Question: Draft a figure caption describing what is shown.
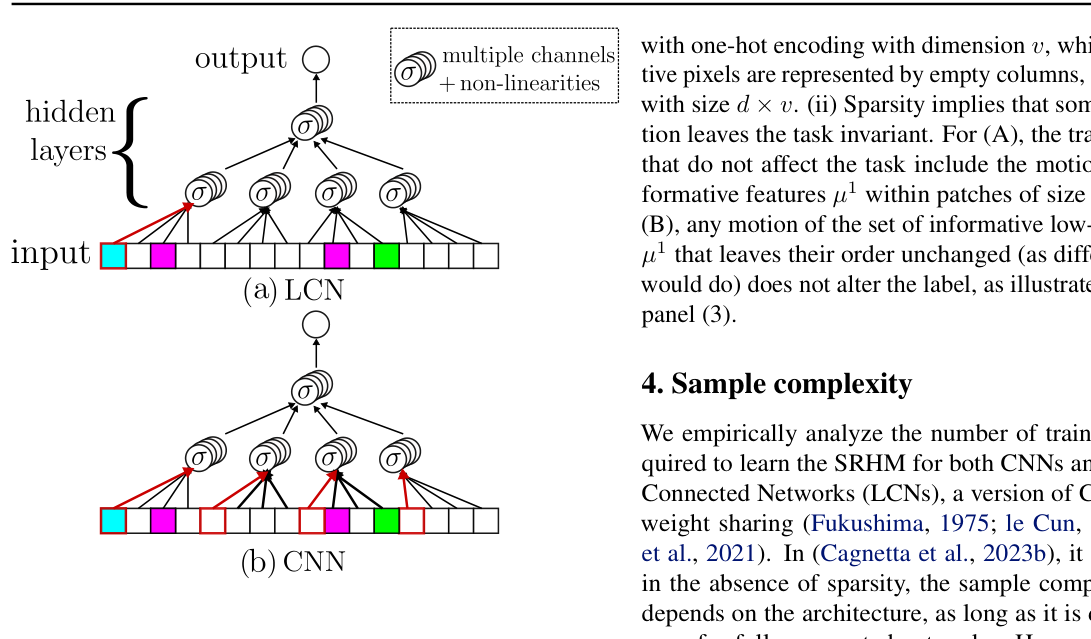
Answer: Networks: (a) Locally Connected Network (LCN). Each neuron’s weight focuses on a single input element (in red). Net- works have L hidden layers, with filters matching patches of size s(s0 + 1) from the generative process in Figure 2 (here L = 2, s = 2, s0 = 1). A last fully connected layer connects the output of the last local layer with the output. (b) Convolutional Neural Network (CNN) with the structure of (a), featuring weight sharing such that each weight considers different pixels in all patches of size s(s0 + 1) (in red).